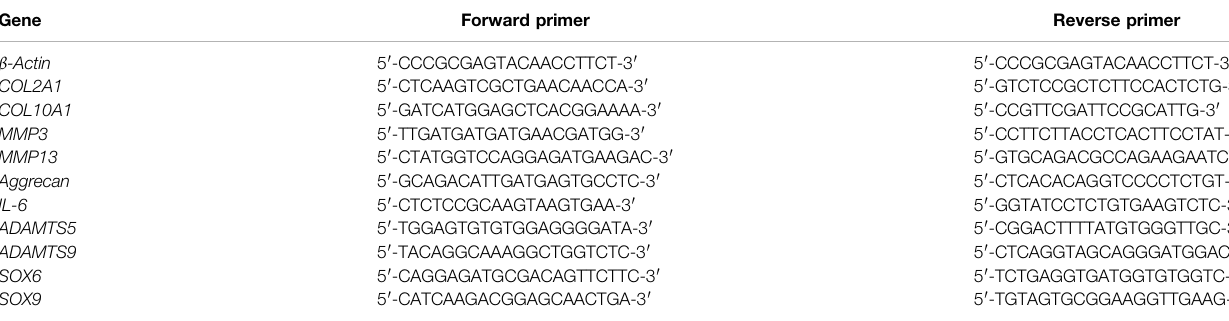
TABLE 1 | Primer sequences of target